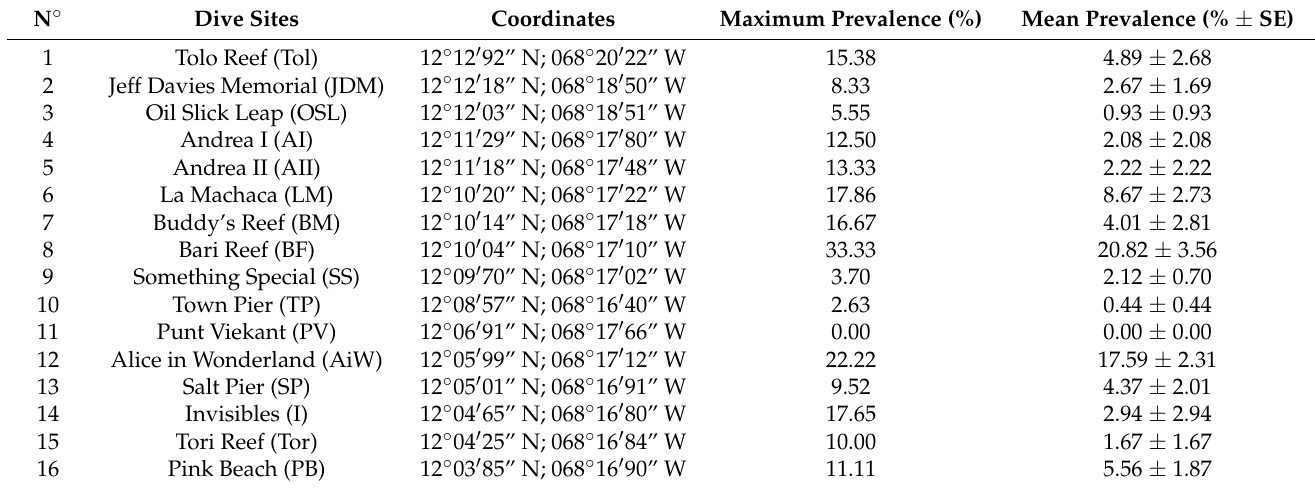
Table 1. Coordinates, maximum and mean value of prevalence of association between sponges and Nemalecium lighti for each of the dive sites considered for the analyses in the study